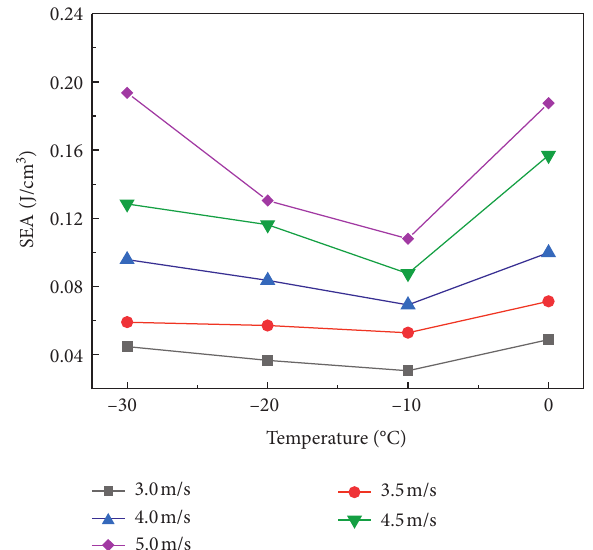
Figure 10: Relationship between SEA and temperature.